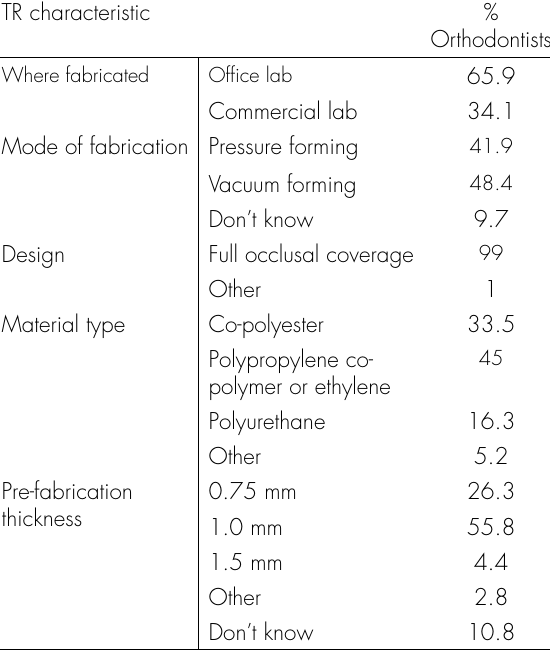
Table VII. Overview of thermoplastic retainer characteristics by